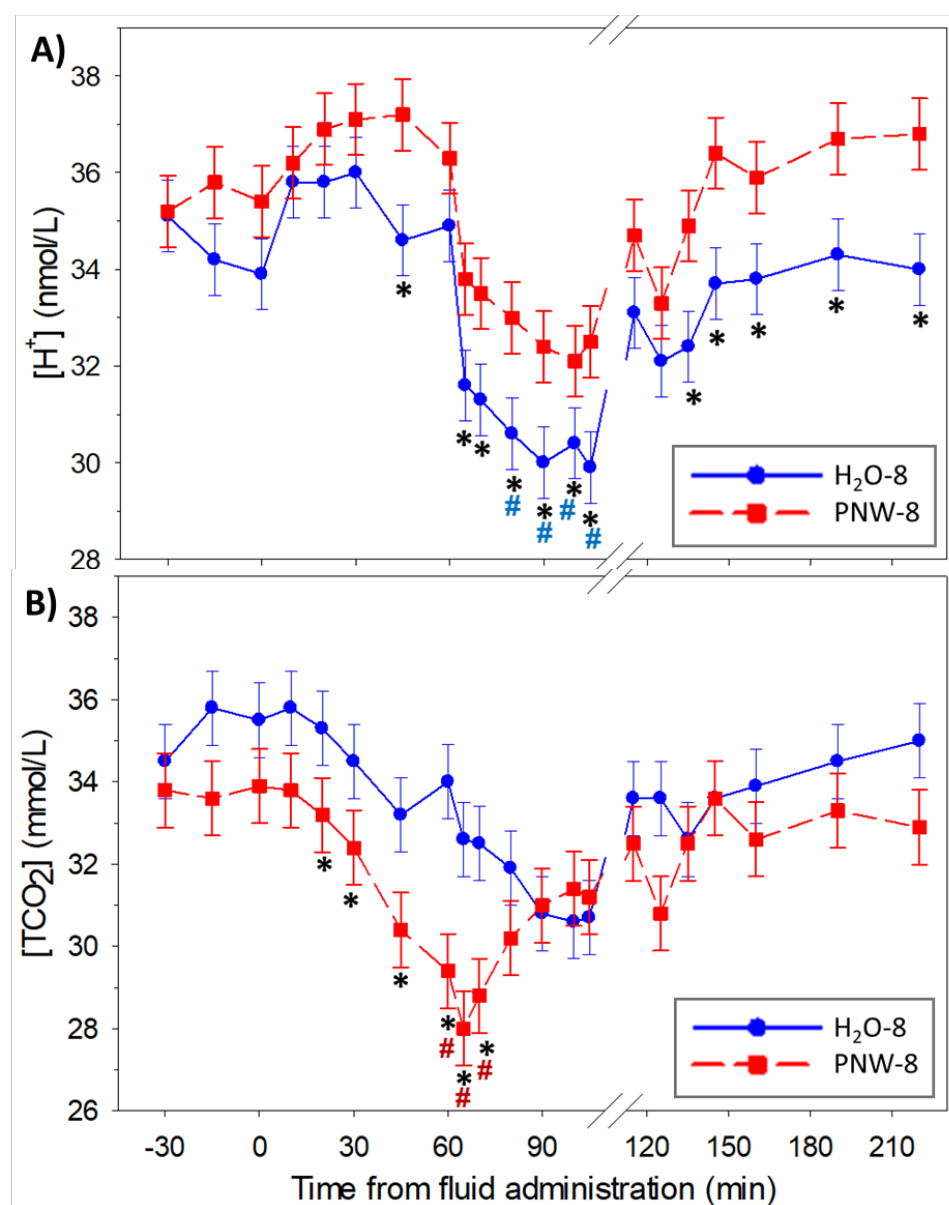
Figure 6. Time course of plasma dependent acid-base variables at rest, during moderate intensity exercise and up to 2 h of recovery. Data are mean ± SEM for plasma concentrations of ( A ) hydrogen ion (H + ) and ( B ) total carbon dioxide ([TCO2]) for n = 4 horses. In a randomized crossover design horses were administered wither 8L of water (control) or a balanced, hypotonic electrolyte solution (PNW-8) 60 min before they exercised on a treadmill at 50% of peak VO2 for 45 min. # and * denote p < 0.05 vs. time 0 and 8L H2O (H2O-8), respectively.